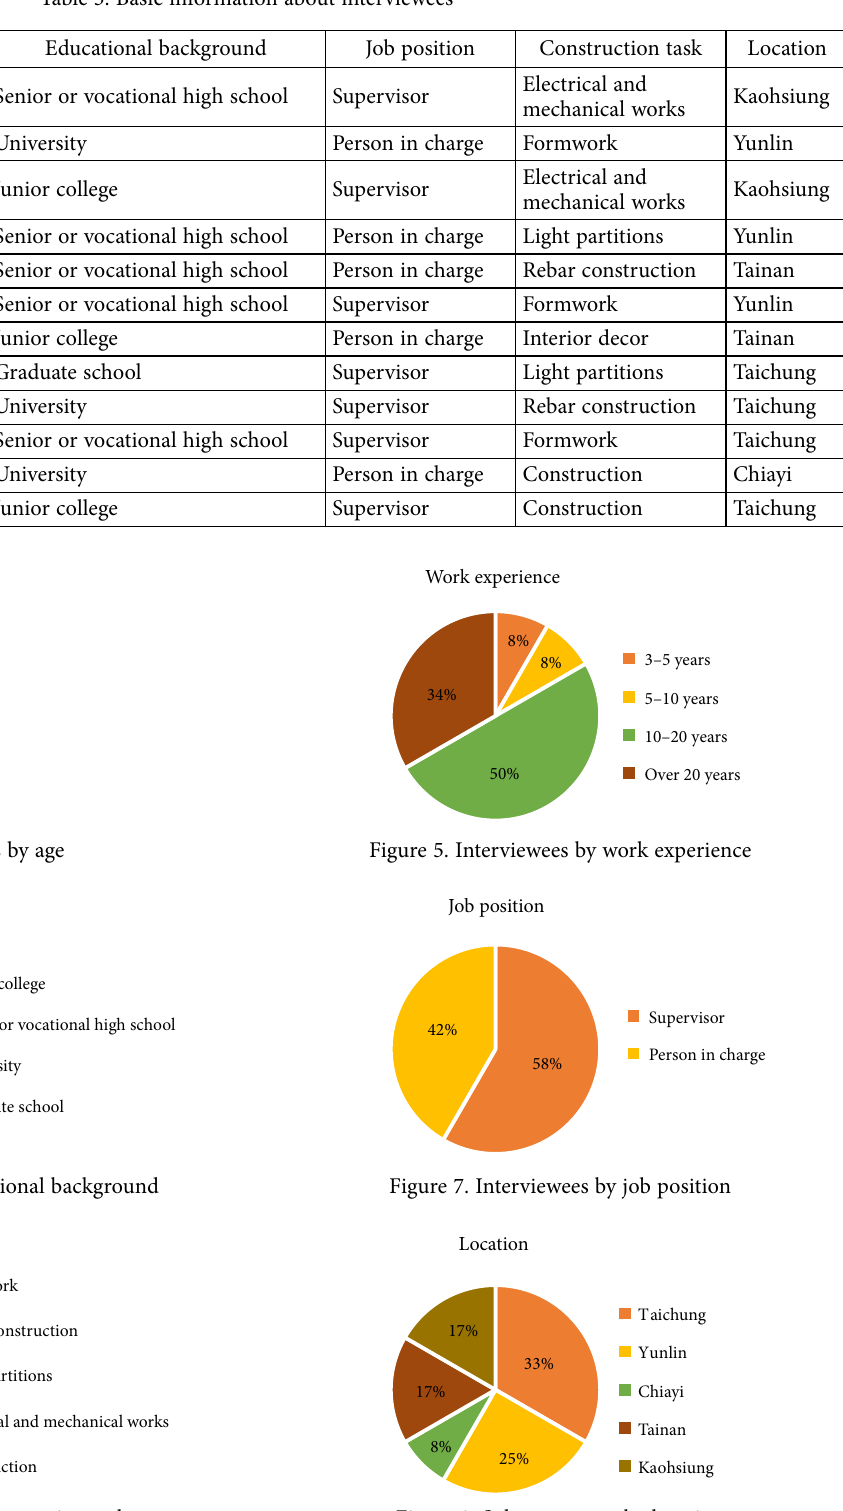
Figure 8. Interviewees by construction task Figure 9. Subcontractors by